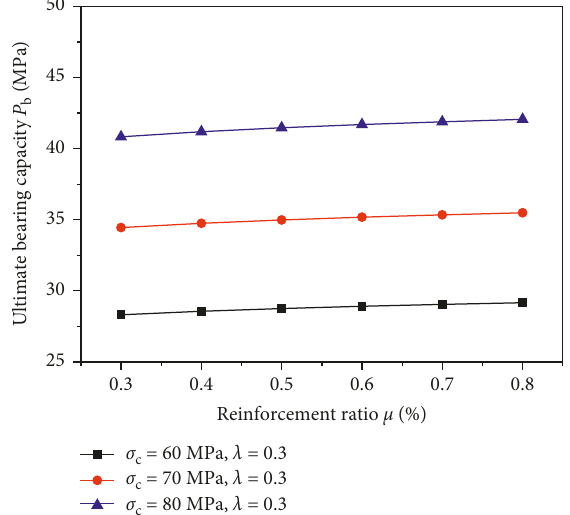
Figure 9: Relationship between ultimate bearing capacity and concrete compressive